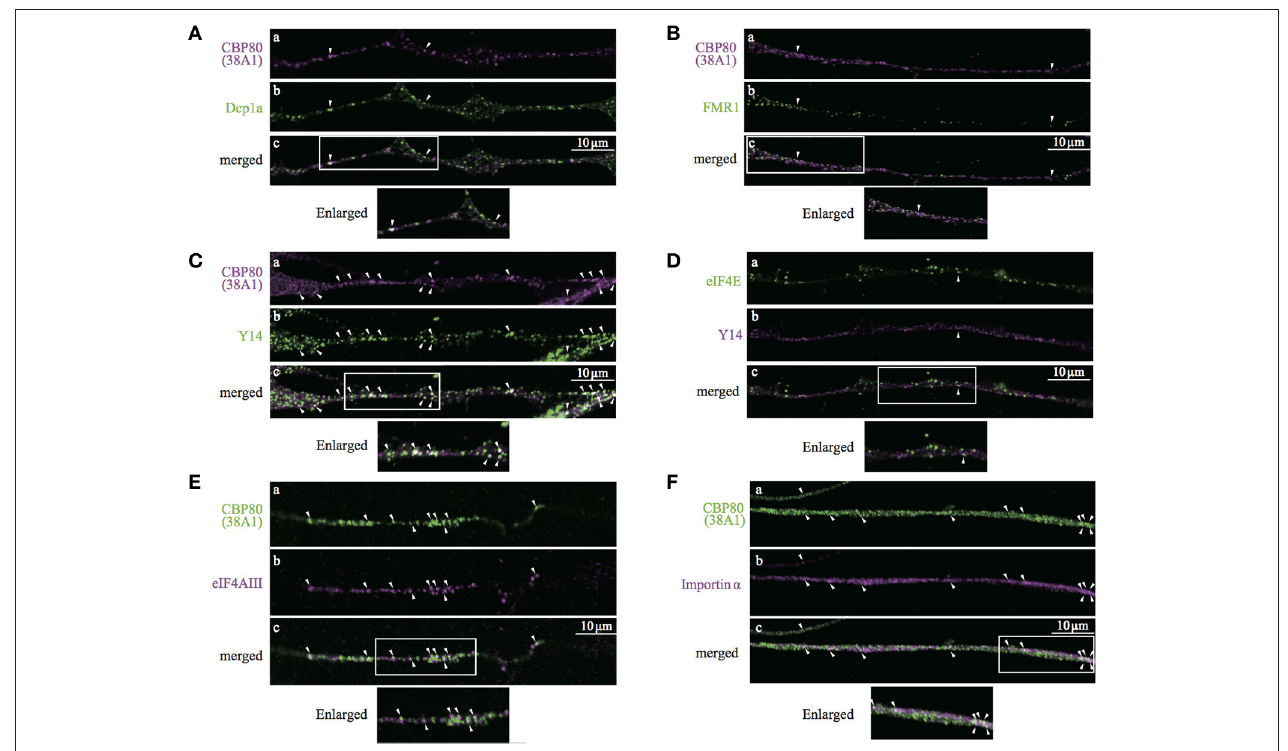
FIGURE 5 | Confocal images of SH-SY5Y neuronal processes double-stained with antibodies against (A) , CBP80 ( a , magenta) and Dcp1a ( b , green); (B) CBP80 ( a , magenta) and FMR1 ( b , green); (C) CBP80 ( a , magenta) and Y14 ( b , green); (D) eIF4E ( a , green) and Y14 ( b , magenta), (E) CBP80 ( a , green) and eIF4AIII ( b , magenta), (F) CBP80 ( a , green) and Importin α ( b , magenta). Merged images are also presented as (c) . Scale bar, 10 µ m. Enlarged images of white boxes are also presented at the bottom of the panels in each